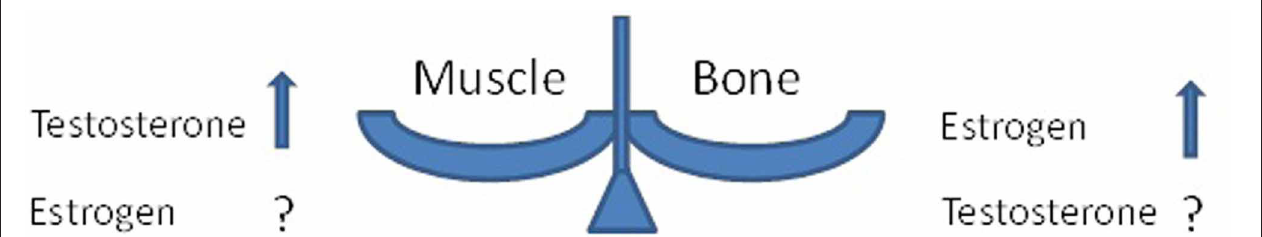
FIGURE 1 | Possible changes in muscle and bone in response to sex hormone